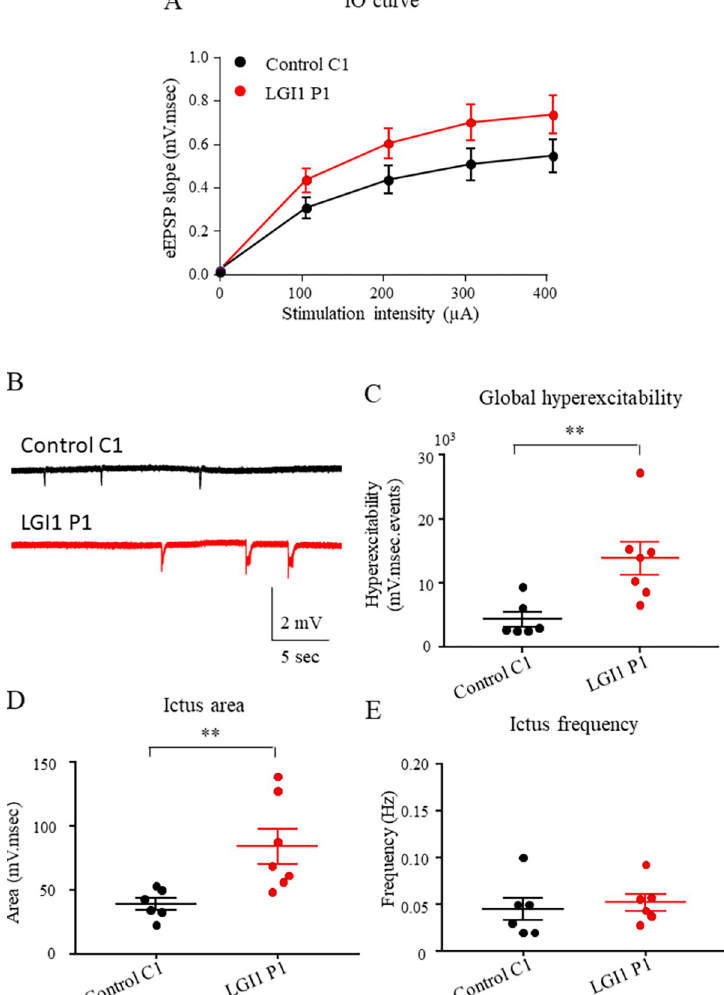
Fig 4. LGI1 abs increase induced neuronal hyperexcitability in the hippocampus. LFP were recorded in CA1 region of acute hippocampal slices from mice infused for 7 days with control C1 IgG, LGI1 P1 IgG. Increasing stimulations intensity were delivered to Schaffer collaterals and the slope of eEPSP in CA1 area were plotted. No effect of the infusion of control C1 IgG, LGI1 P1 IgG on the IO curve was detected (two-way ANOVA test, p = 0.27; n Ctrl = 12; n LGI1 = 14) (A). Examples of ictus recorded in slices infused with control C1 IgG, LGI1 P1 IgG (B). The global hyperexcitability of the neuronal network is increased after LGI1 P1 IgG infusion compared to control C1 IgG infusion (Kruskal-Wallis test � p = 0.02, Dunn’s post Hoc test LGI1-Ctrl �� p = 0.0082) (C) as well as the area of the ictus (Kruskal-Wallis test � p = 0.02, Dunn’s post Hoc test LGI1-Ctrl �� p = 0.12) (D) while frequency is unchanged (Kruskal- Wallis test � p = 0.40, Dunn’s post Hoc test LGI1-Ctrl �� p > 0.99) (E). Data are represented as mean ± SEM (n Ctrl = 6 mice, n LGI1 = 7